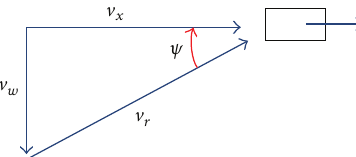
Figure 3: Vehicle wind speed in crosswind